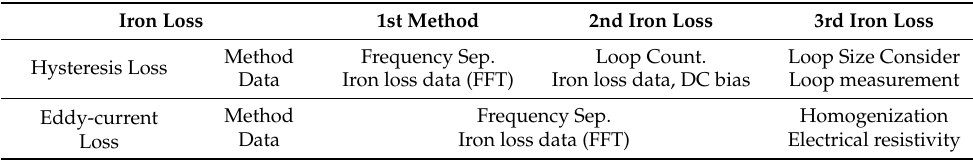
Table 6. Comparison of three different iron losses calculation